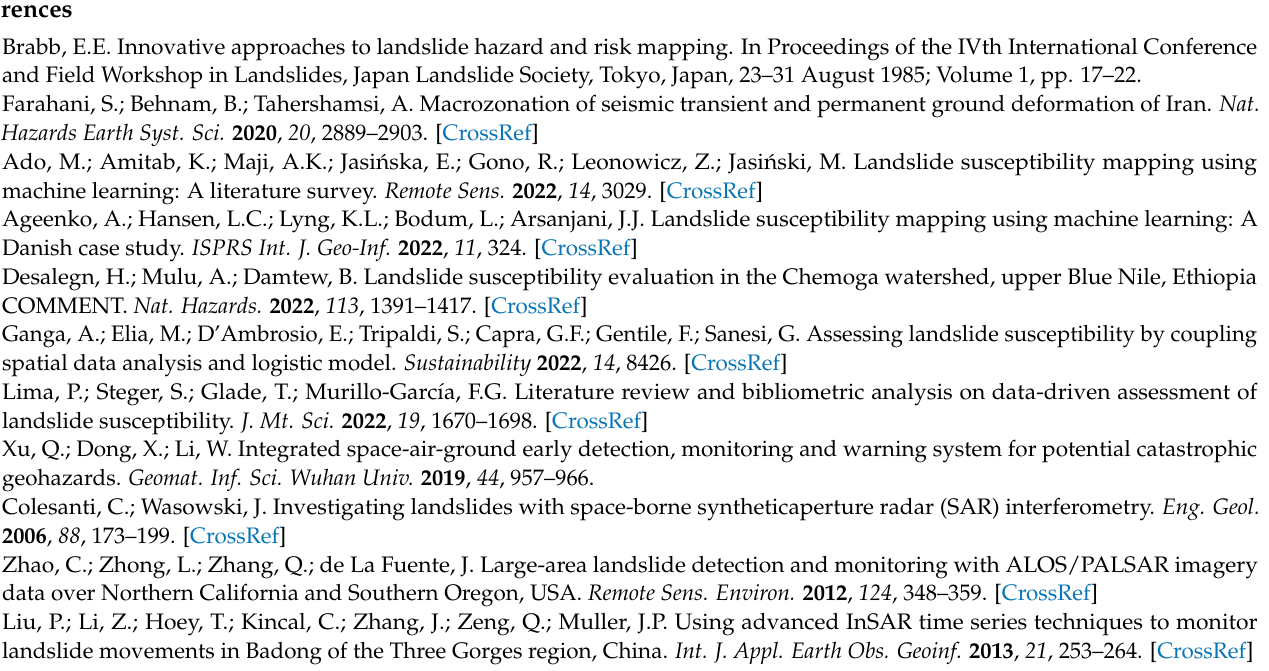
Figure S4: Macroscopical deformation signs of two potential landslide examples (AL-10 and AL-20); Figure S5: Validation of 25 identified active landslides via field survey [62], UAV images [62], and 3D Mapbox images; Figure S6: False alarm regions generated by SBAS-InSAR technique superimposed on (a) Deformation velocity map and (b) Google Earth images shot on 2 February 2015; 16 March alarms; Table S1: Geoenvironmental features of 25 active landslides; Table S2: Correlation of active landslide deformation with various triggering factors; Table S3 Collinearity relation among various disaster-controlling and disaster-triggering